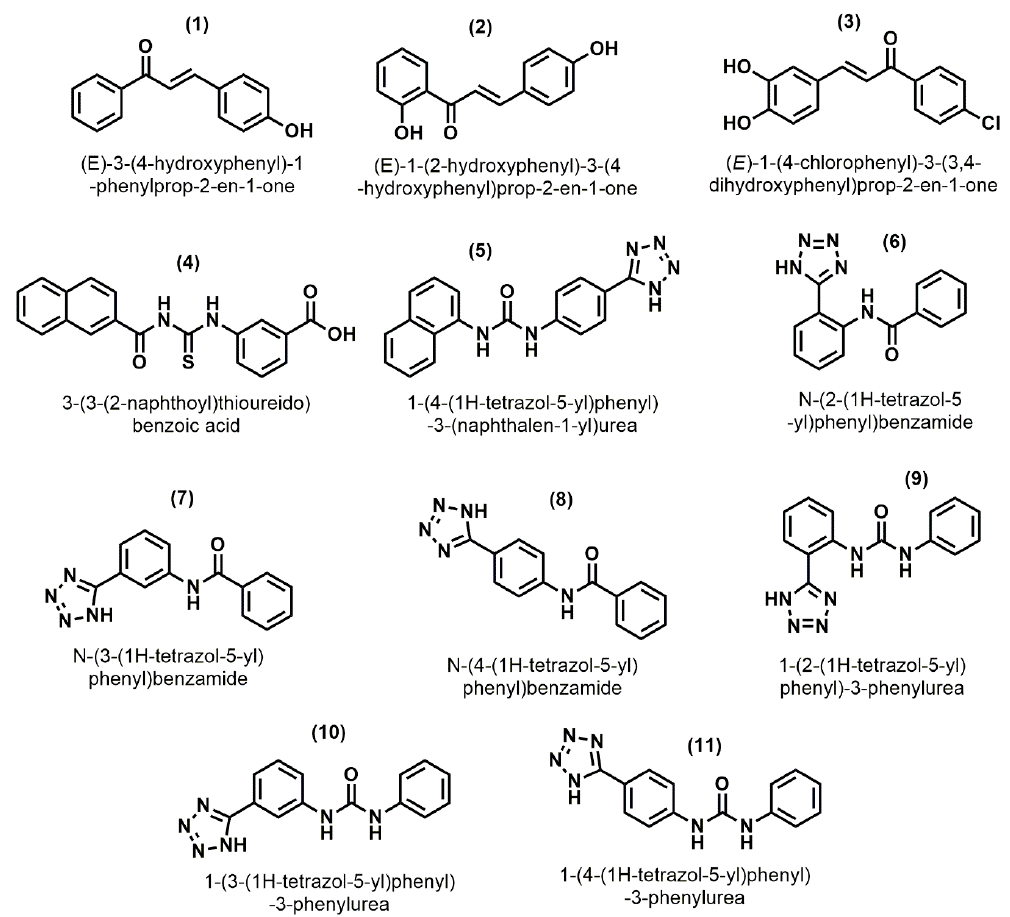
Figure 7. 2D Structure of reported inhibitors against CXCL12.